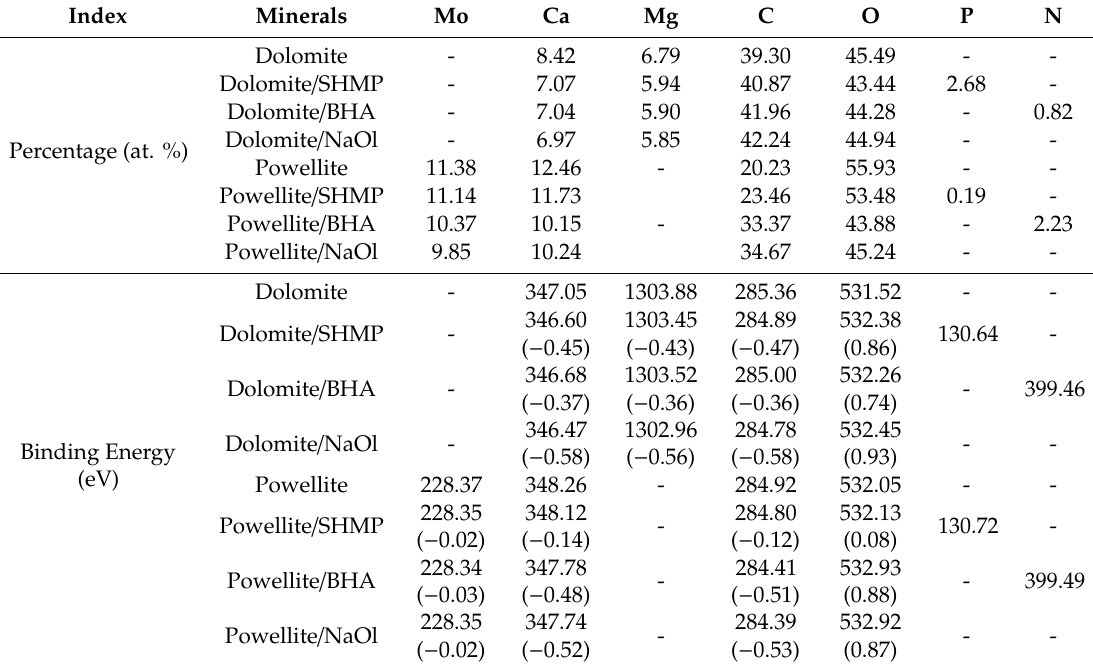
Table 2. Binding energy and percentage of component elements on the mineral